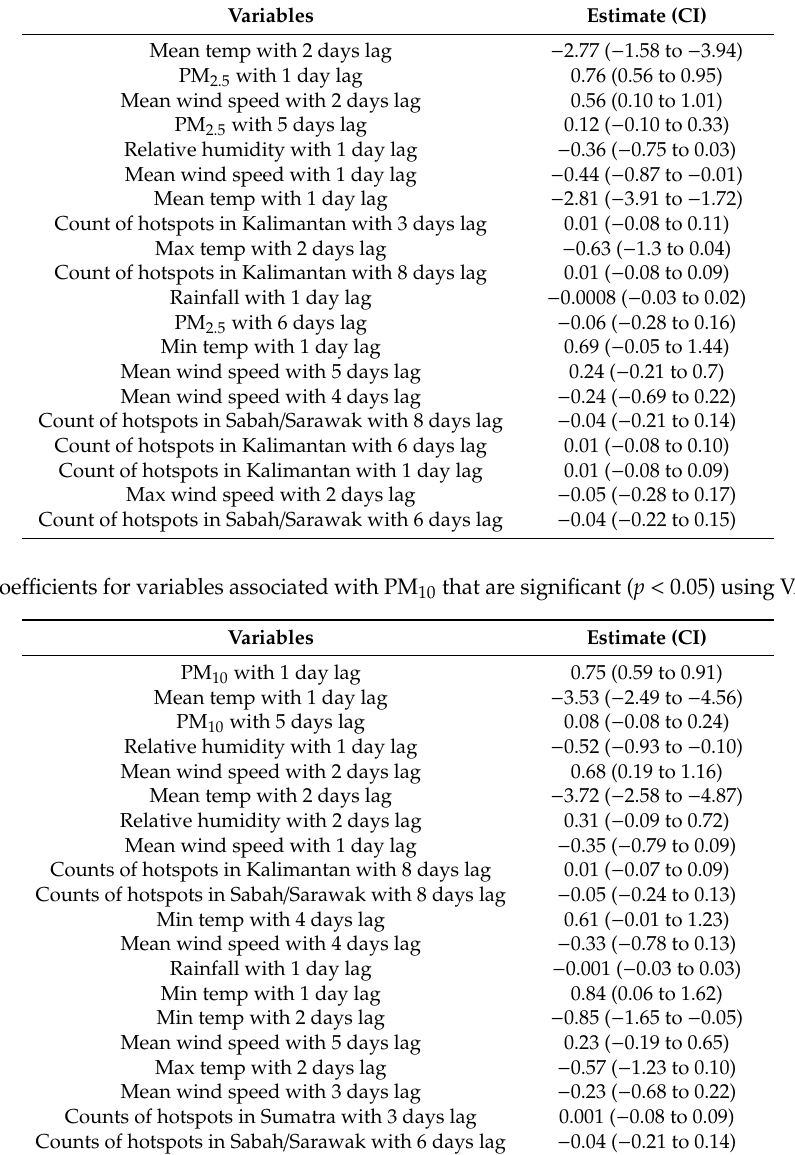
Table 1. Coe ffi cients for variables associated with PM 2.5 that are significant ( p < 0.05) using vector autoregressive (VAR) model.